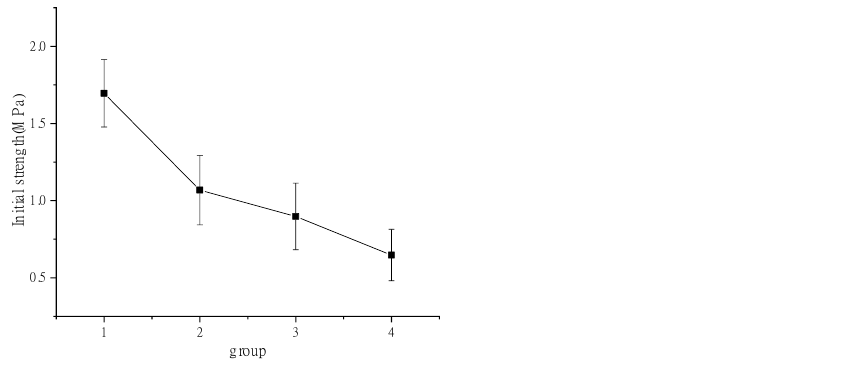
Figure 9. Initial compressive strength of each group. After completing the experiment, the data obtained from the experiment are processed. The influence of different lime-sand concentration ratios on the uniaxial compressive strength are measured. Figure 10 shows the data after processing.